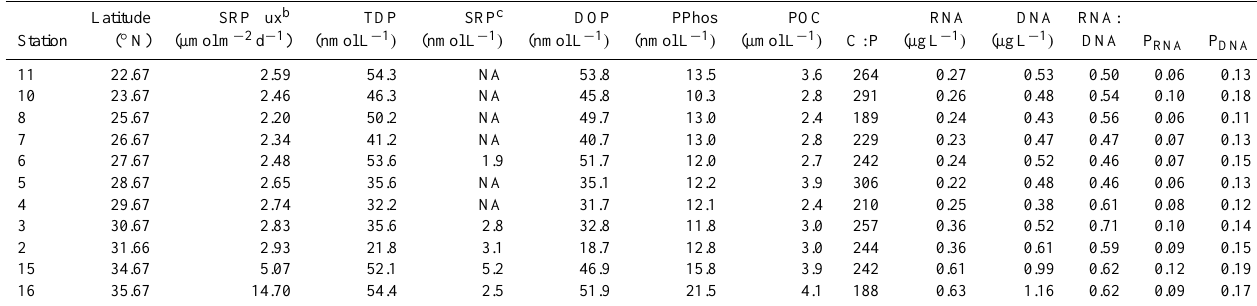
Table 1. Summary of abiotic and biotic transect parameters a , including surface concentrations and upward flux of SRP and concentrations of TDP, DOP, PPhos, POC, and nucleic acids (RNA and DNA). Particulate C:P molar ratios and proportions of total PPhos in RNA and DNA (P RNA and P DNA ) were also calculated. Latitude SRP flux b TDP SRP c DOP PPhos POC RNA DNA RNA: